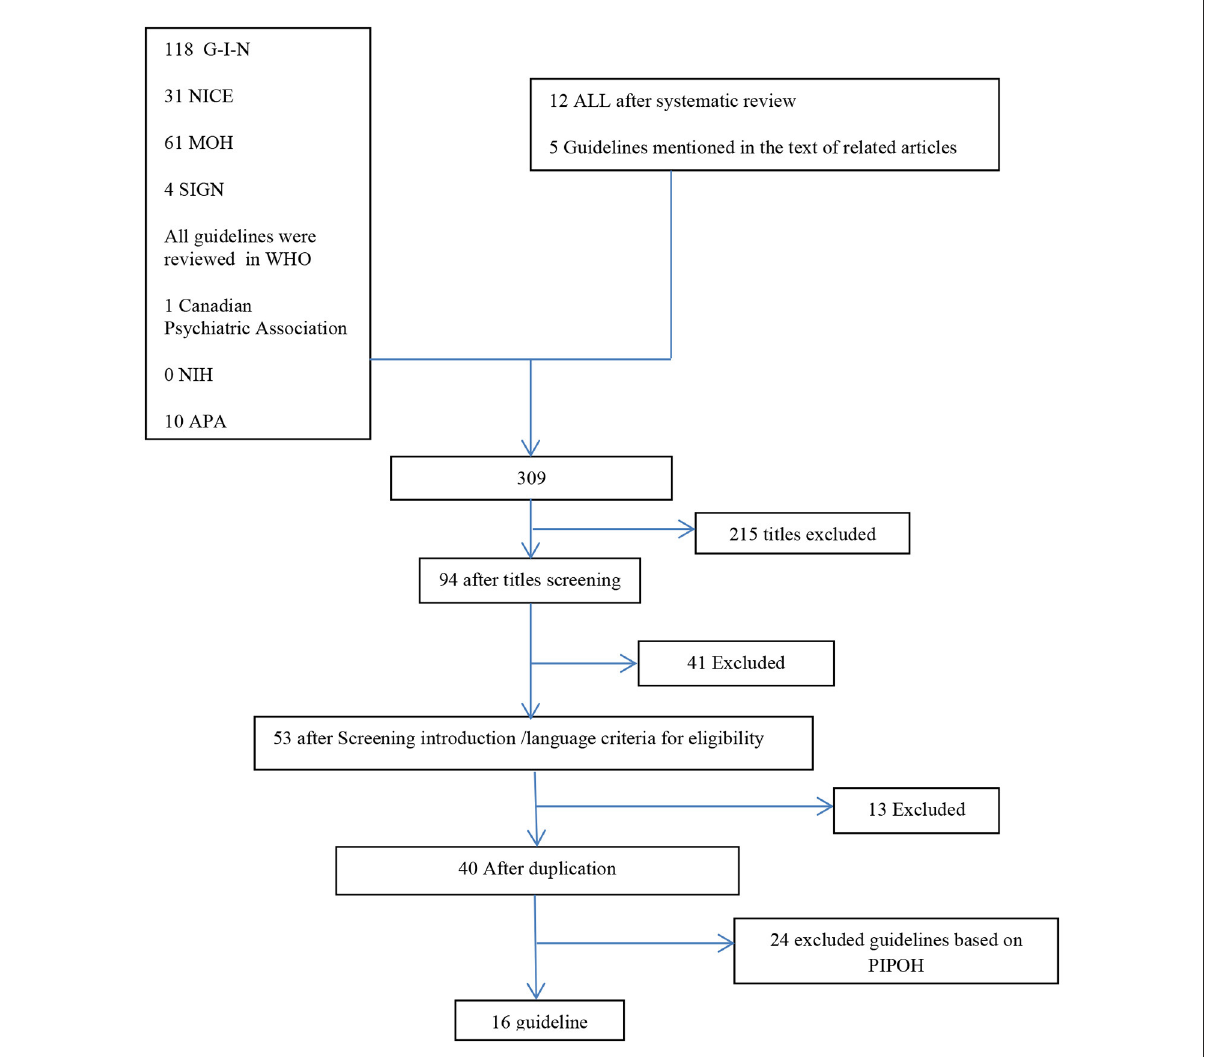
FIGURE1 Diagram for the inclusion and exclusion of